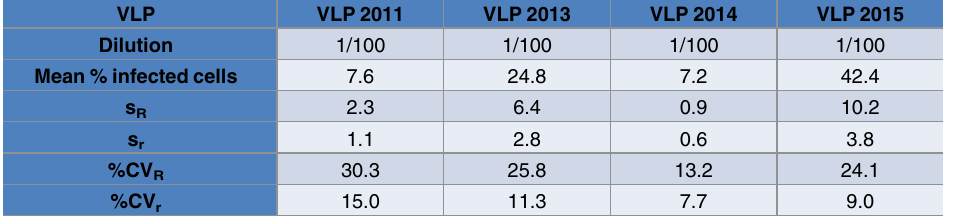
Table 1. Inter and intra-assay variability of infection with WNVV/YFV17D VLP 2011, VLP 2013, VLP 2014, VLP 2015 in Vero cell lines in 5 different sera collected before 17D-